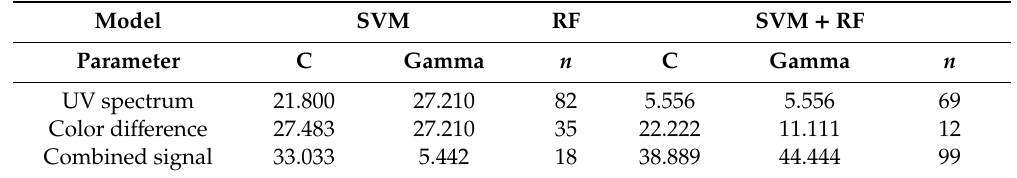
Table 2. The optimum parameter based on UV spectrum, color di ff erence, combined signal using the three